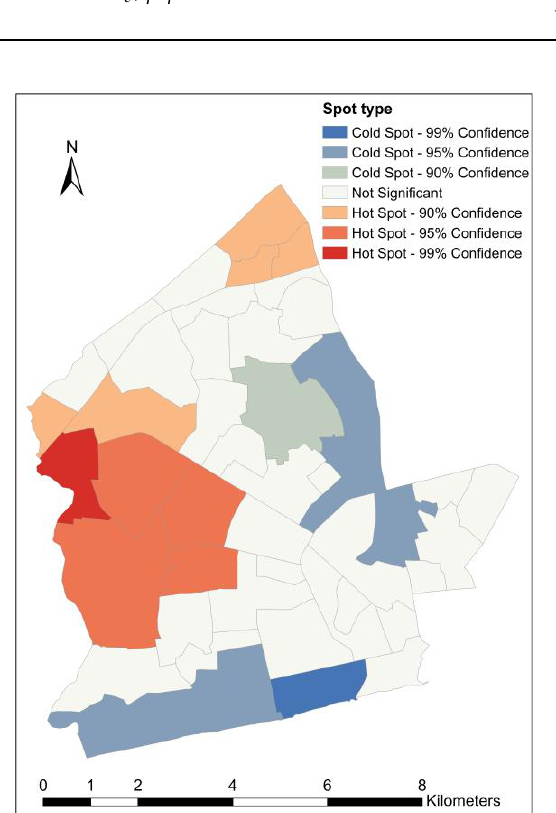
Figure 10. Hot/cold spot neighborhoods for load shedding exposure. Figure 10. Hot / cold spot neighborhoods for load shedding